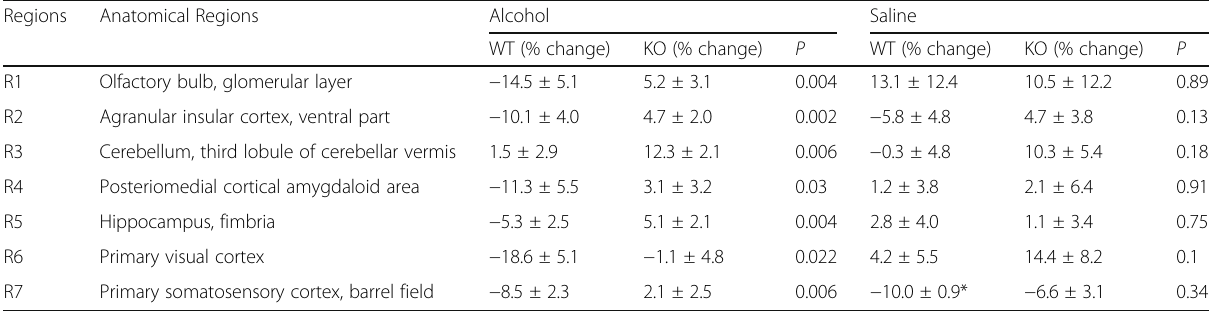
Table 5 Regional metabolic activity in regions identified by the two way ANOVA analysis. Percent changes in regional metabolic activity in the WT and CIRP − / − mice treated with alcohol or normal saline (mean ± SE). ** P < 0.01 between pre- and post-saline treatment within